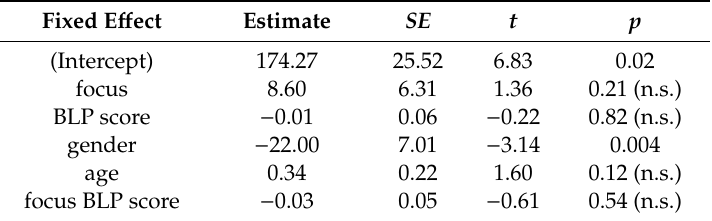
Table 5. Results of the mixed-effects model for stressed syllables in object position ( N = 262).